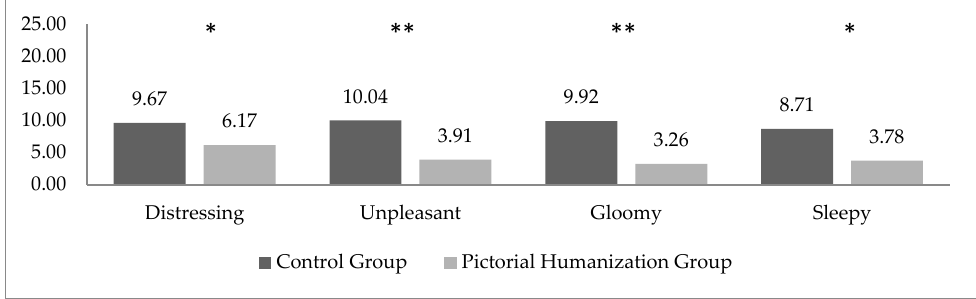
scale (F(1,45) = 0.289; p = 0.594) (Figure 1).